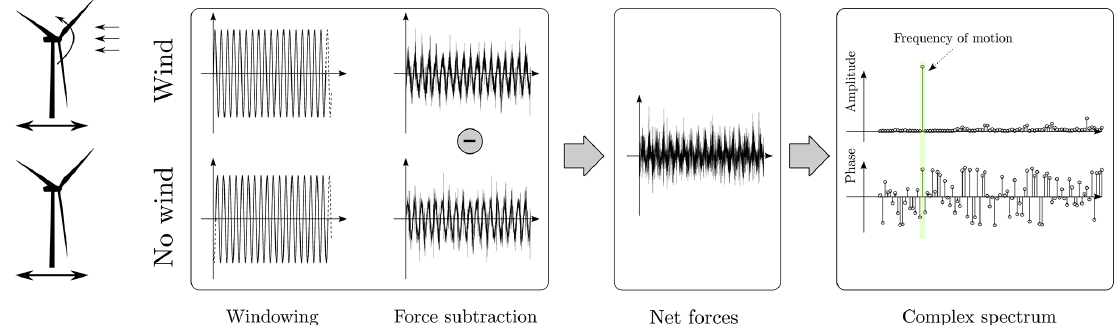
Figure 4. Scheme of the post-processing applied to force measurements in tests with a moving turbine. Two tests are carried out for every motion condition, one with wind and a spinning rotor and one without wind and with a still rotor. Time series from the two tests are windowed so as to have the same integer number of motion periods. Then, forces from the test with no wind are subtracted from forces with wind. The resulting forces are examined taking the complex spectrum and studying the harmonic content at the frequency of the imposed motion (amplitude and